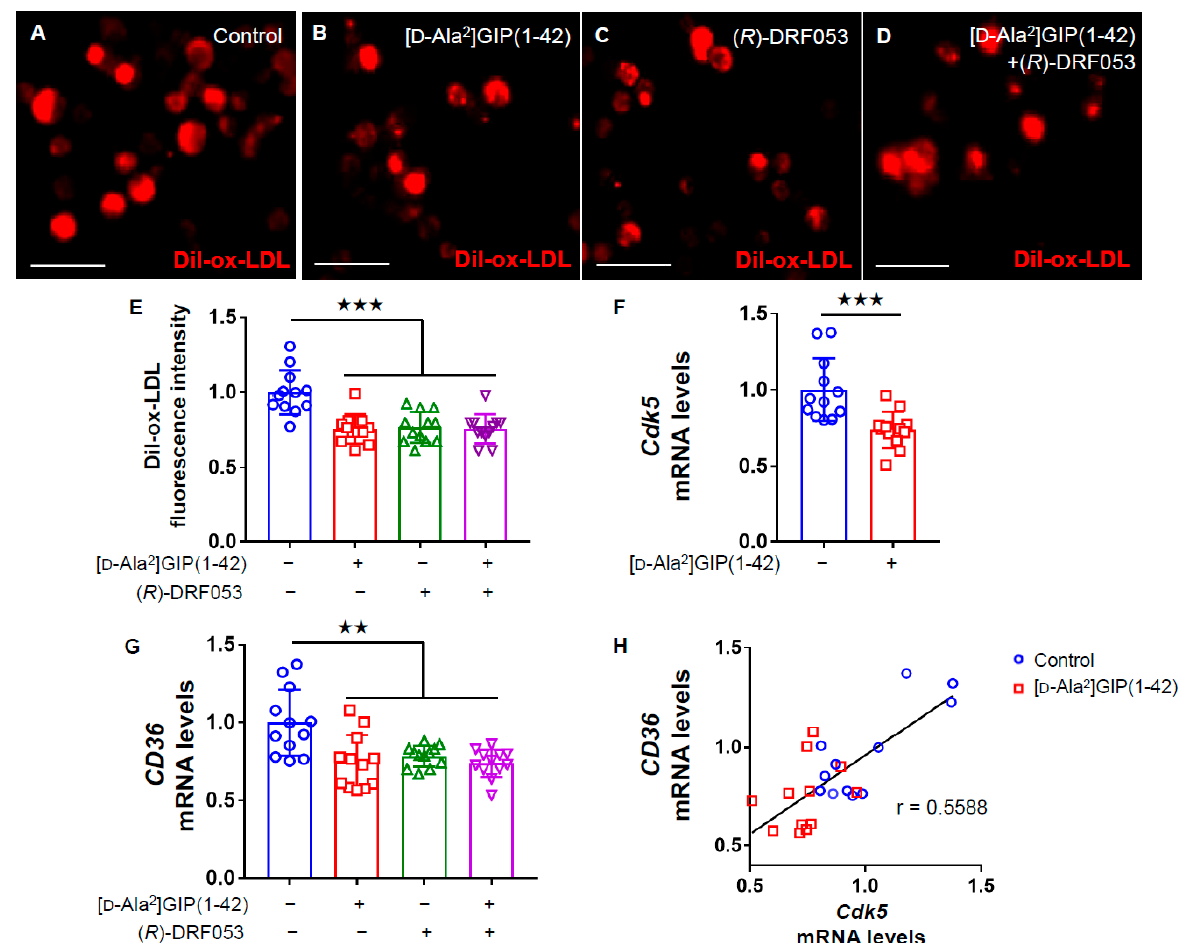
Figure 2. Effects of [ D -Ala 2 ]GIP(1–42) and ( R )-DRF053 dihydrochloride on Dil-ox-LDL uptake, Cdk5 and CD36 gene expression in U937 cells. U937 were incubated with 10 μ g/mL Dil-ox-LDL with or without 1 nmol/L [ D -Ala 2 ]GIP(1–42) or 0.215 μ mol/L, a selective inhibitor of Cdk5 ( R )-DRF053 dihydrochloride in RPMI 1640 medium supplemented with 10% FCS containing 100 U/mL penicillin and 100 ug/mL streptomycin at 37 °C for 18 h. ( A – D ) Representative immunofluorescent staining images in human U937 macrophages. Dil-ox-LDL-positive cells were stained in red. Scale bars, 50 μ m. ( E ) Quantification of fluorescence intensity in red. Dil-ox-LDL uptake was normalized by the control values. ( F – H ) Gene expression levels of Cdk5 ( F ), and CD36 ( G ), and their correlation ( H ). Total RNAs were transcribed and amplified by real-time PCR. Data were normalized by the value of GAPDH mRNA-derived signals and then related to the control intensities. Number = 12 for each group. Error bars are standard deviation. ★★★ p < 0.005, ★★ p < 0.01 vs. control.